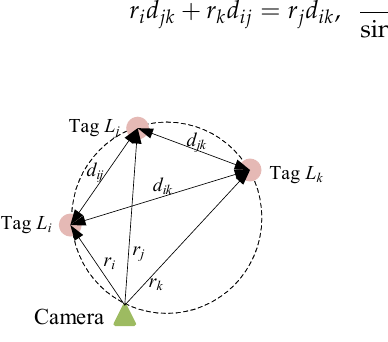
Figure 6. Schematic for cocircular condition.